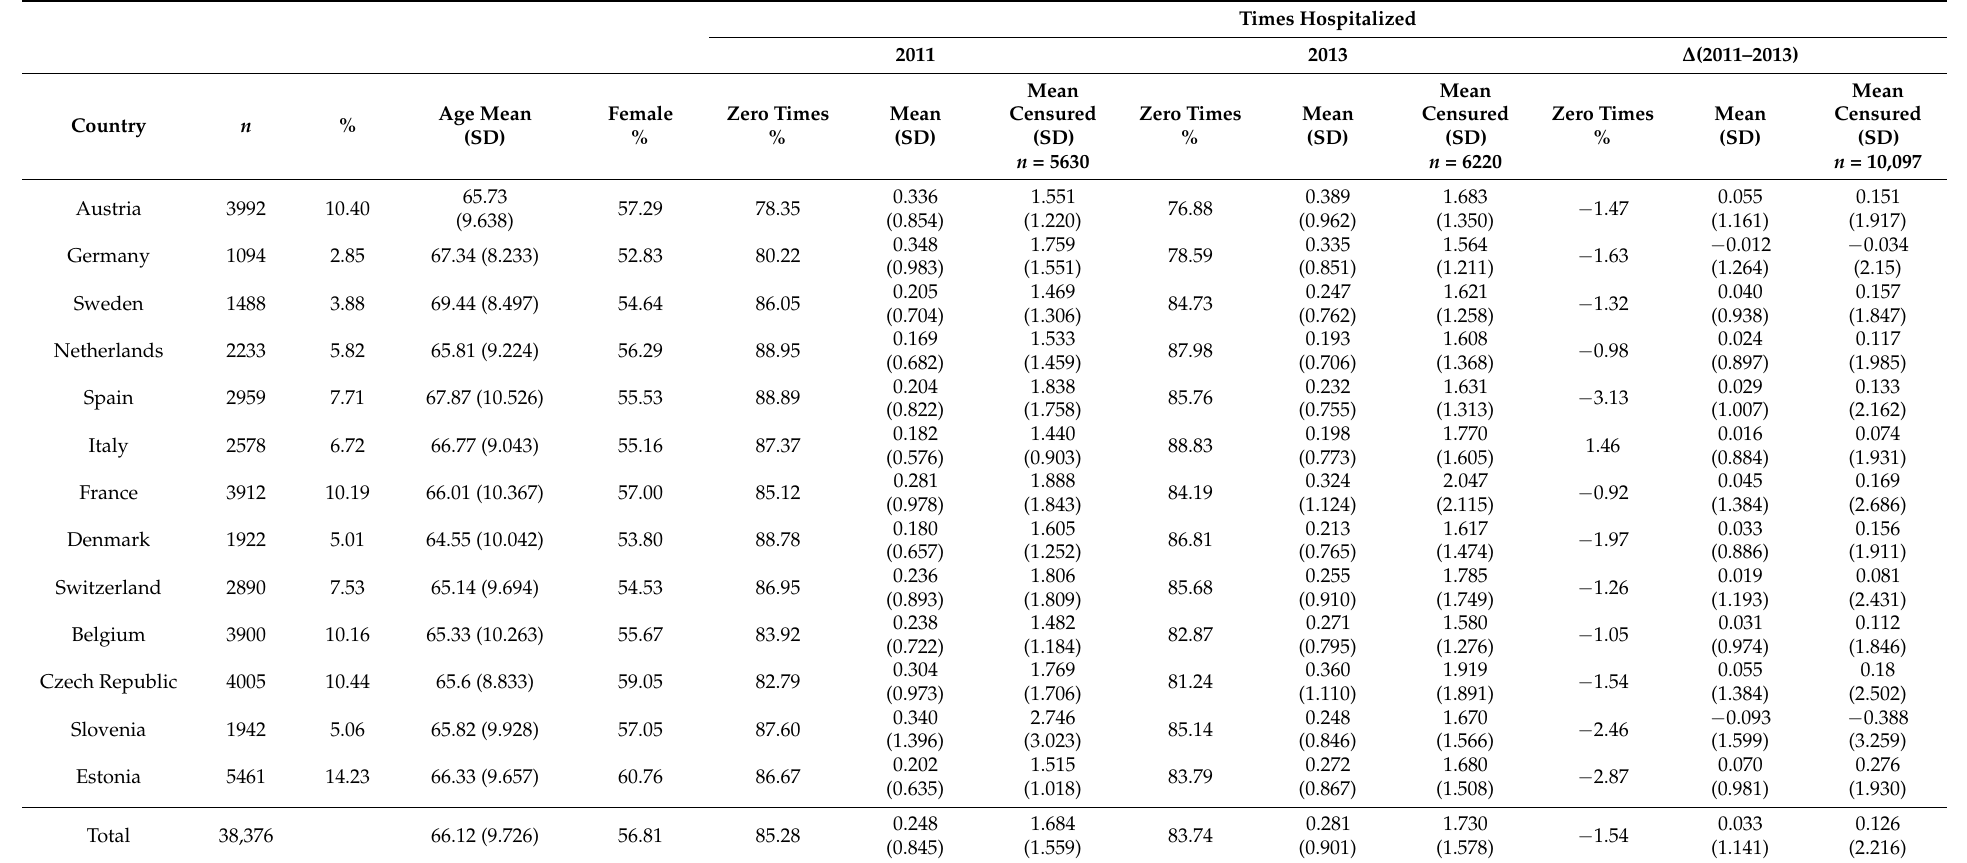
Table 1. Descriptive statistics of the study sample and times hospitalized by